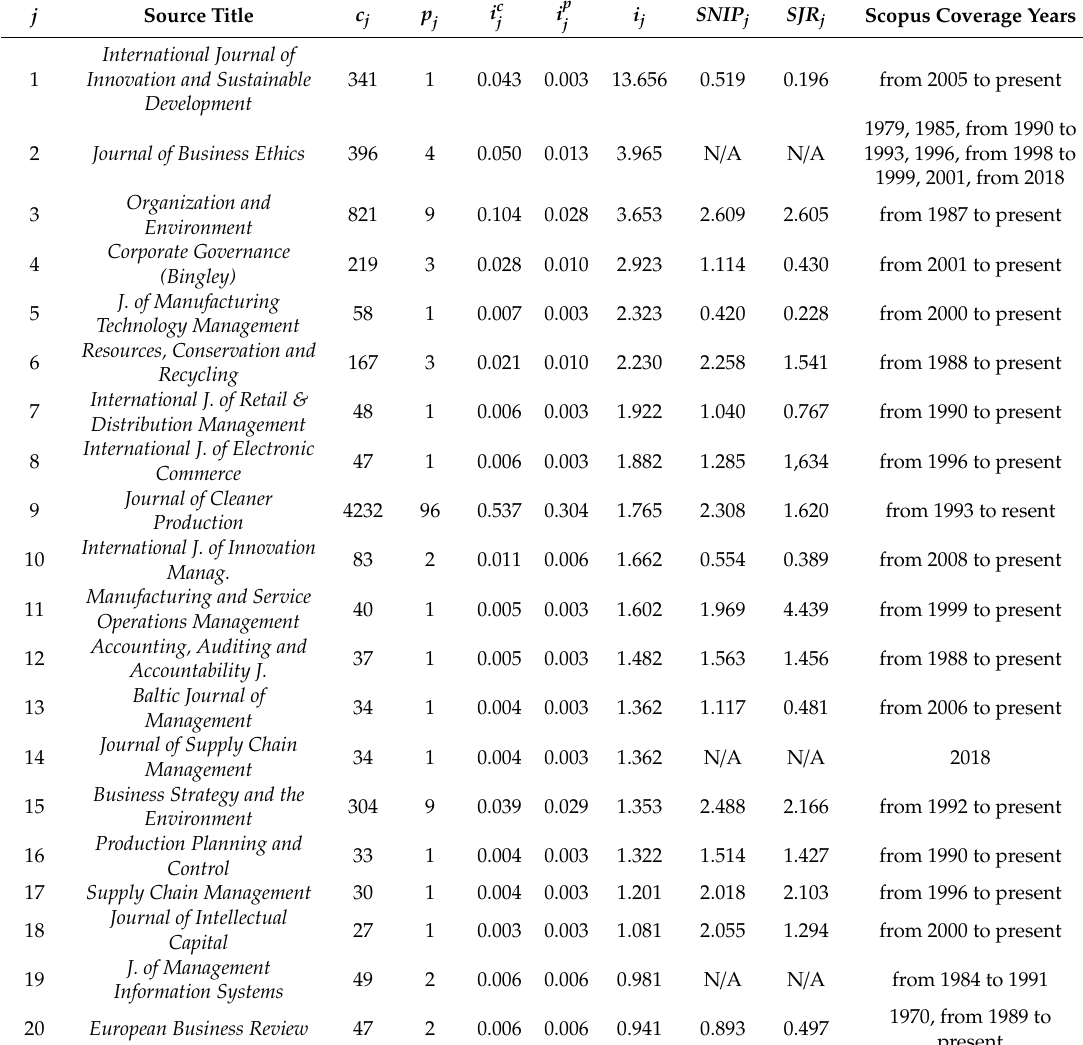
Table 6. High impact journals in sustainable business models